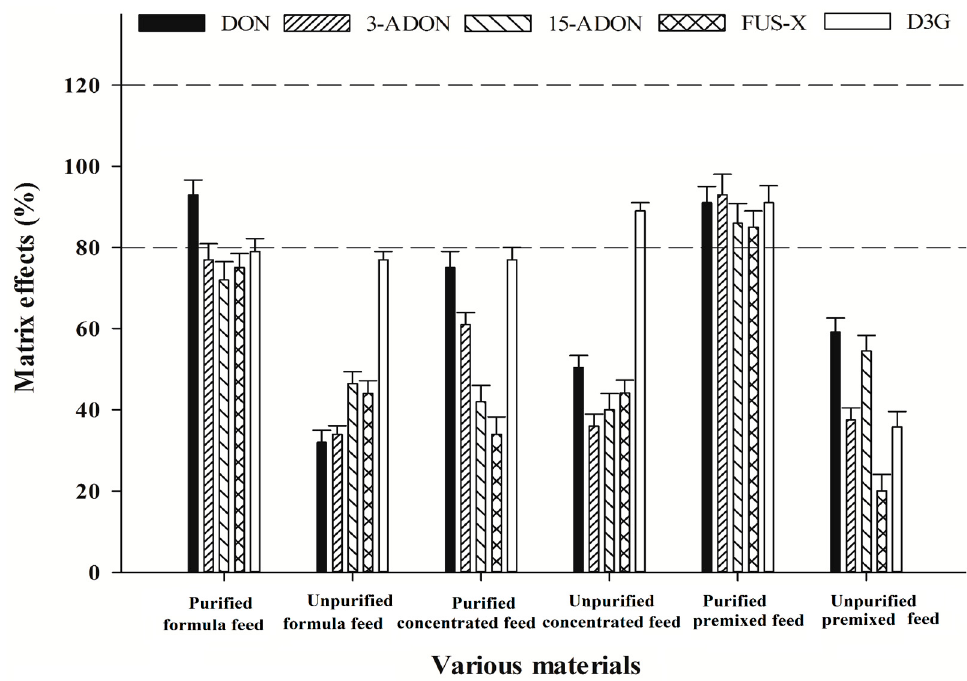
Figure 3. The matrix effectsof the five targeted mycotoxins in different feed matrices purified or not purified by HLB cartridges( n = 3). The spiked concentration level is 50 μ g/kg for each mycotoxin. The tolerance level of matrix effects is in the range of the two dashed lines (80%–120%).